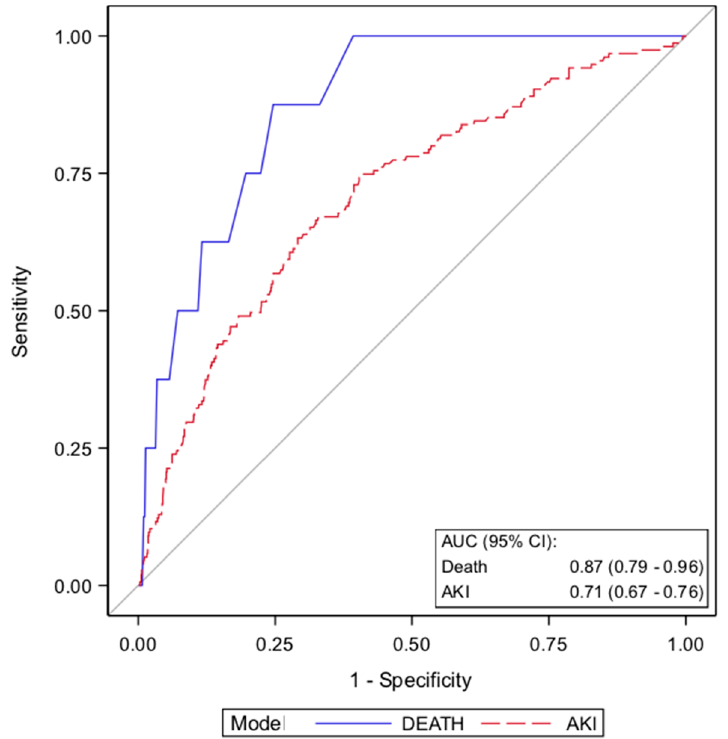
Figure 2. Receiver operating characteristics (ROC) curves for the prediction of AKI (red) and death (blue) after elective cardiac surgery. The grey line indicates the reference values of a diagnostic test that is no better than chance level.